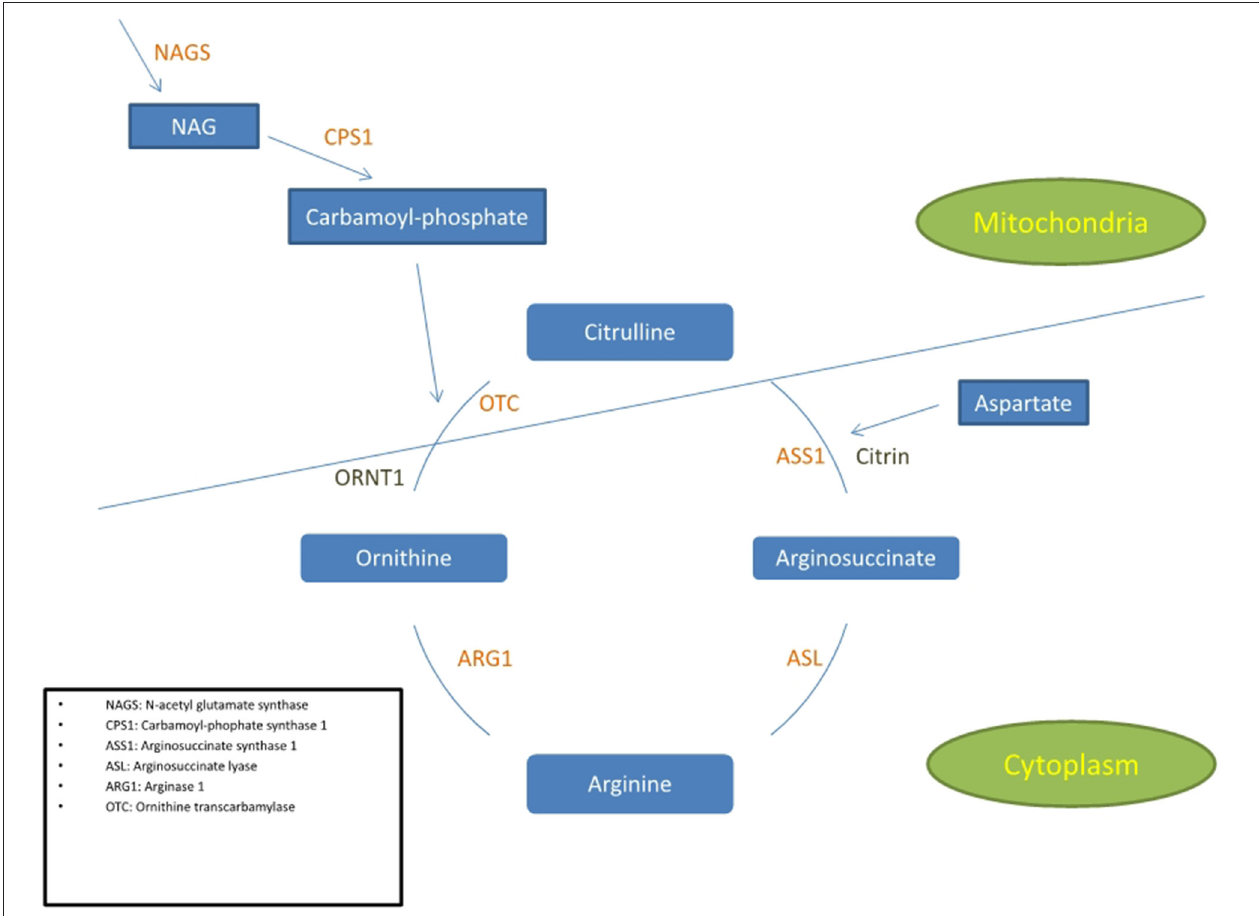
FIGURE 1 | Simplified diagram of the urea cycle indicating the 6 enzymes and 2 transporters associated with UCD. The cycle is partly in the cytoplasm and partly in the mitochondria. The 3 enzymes positioned in the inner mitochondrial membrane are NAGS, CPS1, and